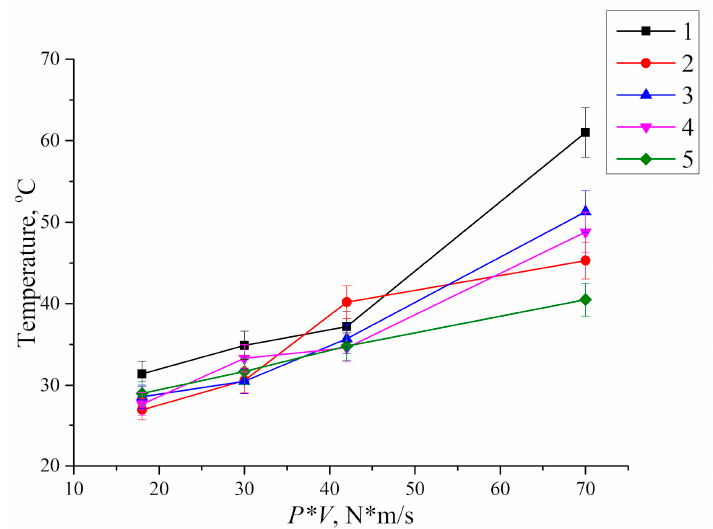
Figure 18. Counterpart temperature vs. P · V tribological loading parameter: 1—UHMWPE; 2—UHMWPE + 0.5% CNF; 3—UHMWPE + 10% CF; 4—UHMWPE + 10% LCF; 5—UHMWPE + 10% HDPE-g-SMA + 2% LCF + 0.5%